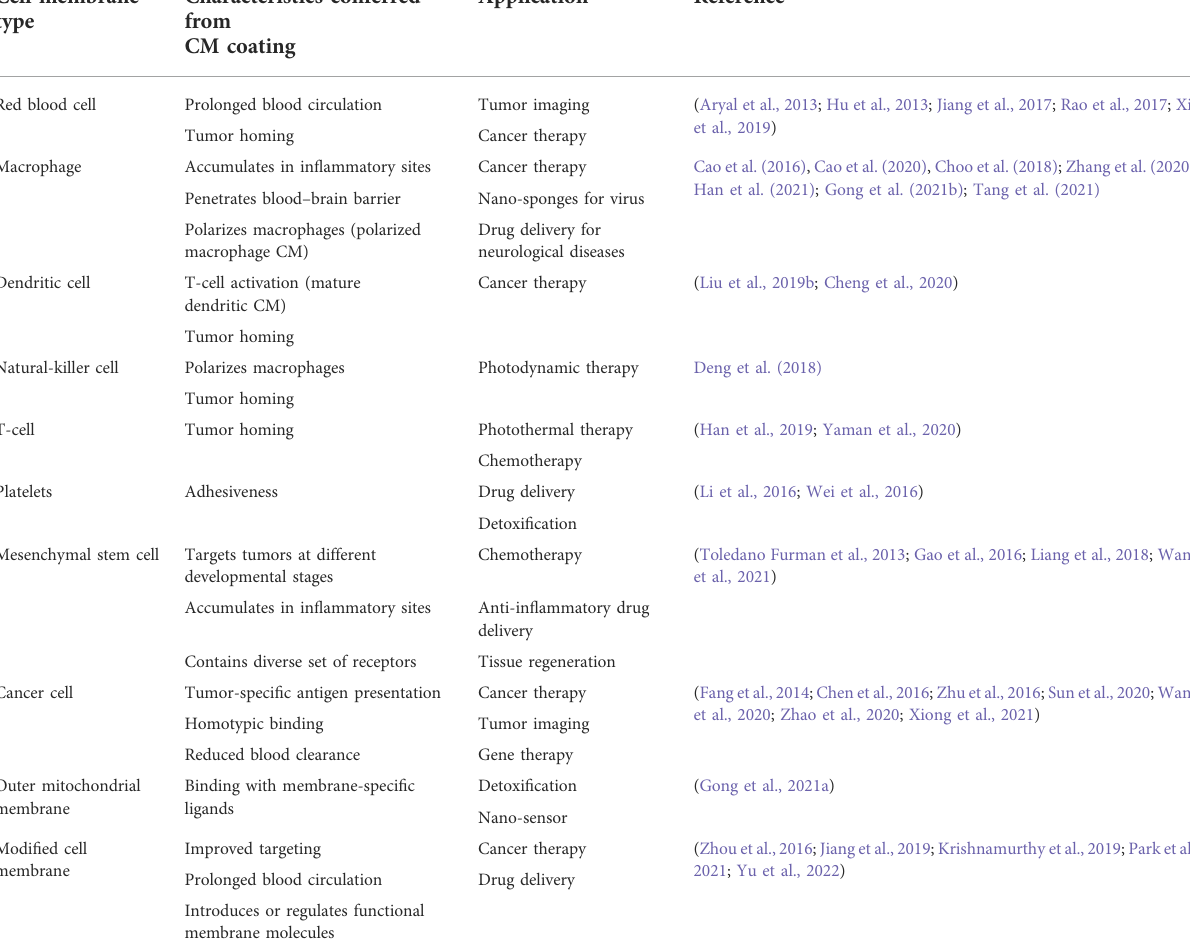
TABLE 2 Characteristics conferred from different CMs and their